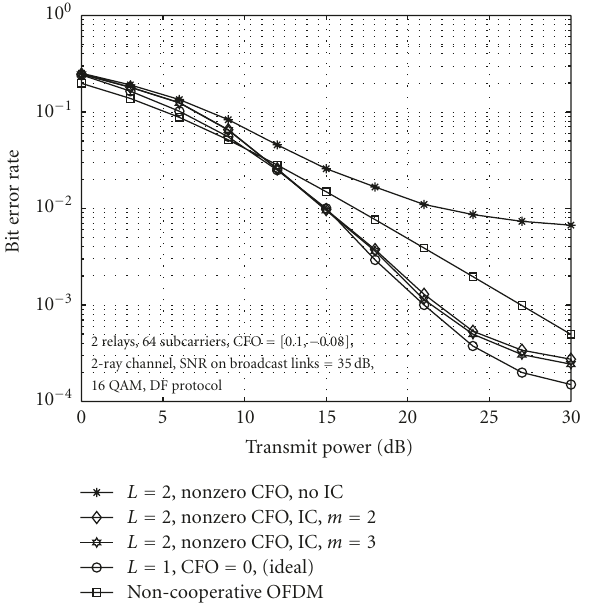
Figure 7: BER performance as a function of SNR for CO-SFBC- OFDM on frequency-selective fading ( L = 2). M = 64, 2 relays ( N = 2, G 2 code), CFO = [0.1, − 0.08], 16-QAM, SNR in broadcast links = 35 dB. DF protocol at the relays.